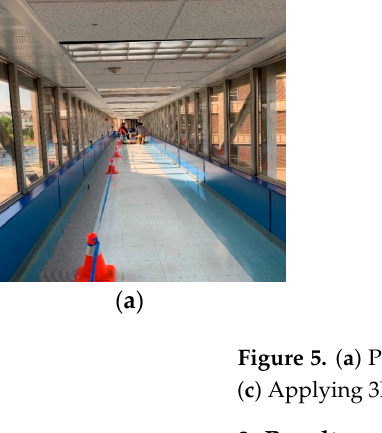
Figure 5 . ( a ) Placing the sensing textile. ( b ) Extending the sensing textile to an optical fiber spool. ( c ) Applying 3M Hi-Strength 90 spray adhesive between the floor and the sensing textile.